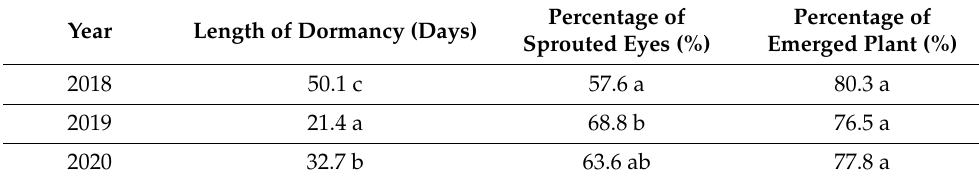
Table 8. Differentiation of tested factors depending on